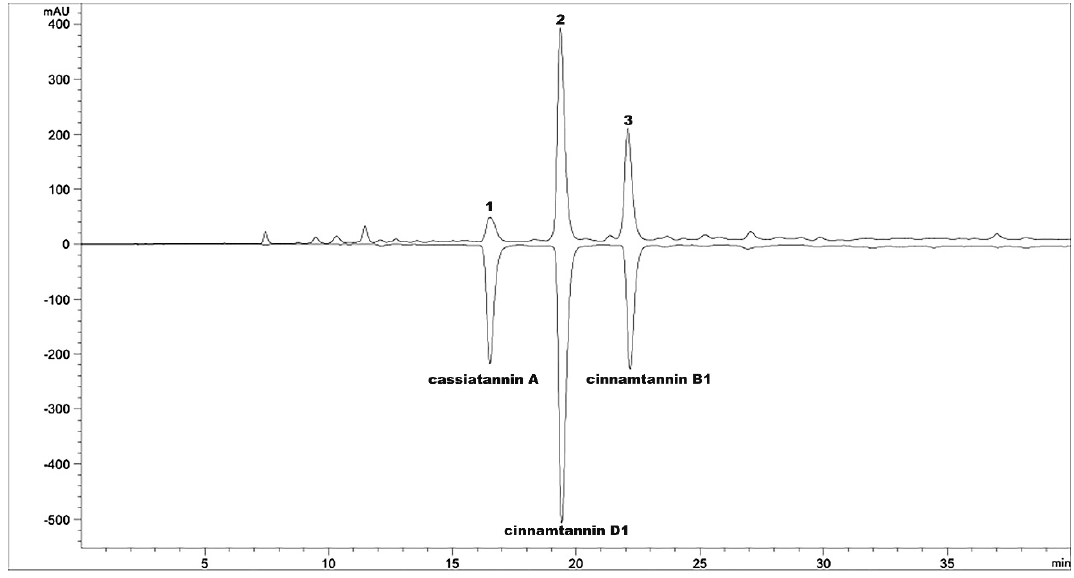
Figure 10. RP-HPLC chromatographic profile of OPCs detected at 280 nm. Peak 1 was A-type tetramer cassiatannin A, peaks 2 and 3 were A-type trimers, cinnamtannin D1 and cinnamtannin B1, respectively.